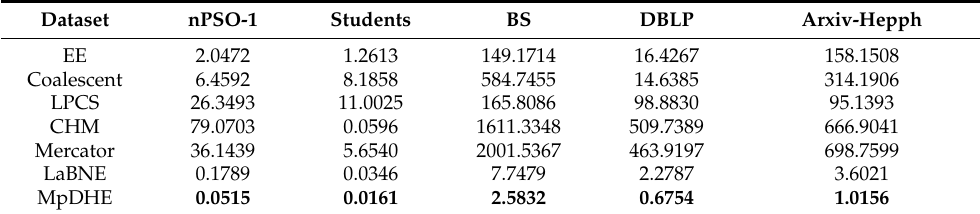
Table 5. The time for network